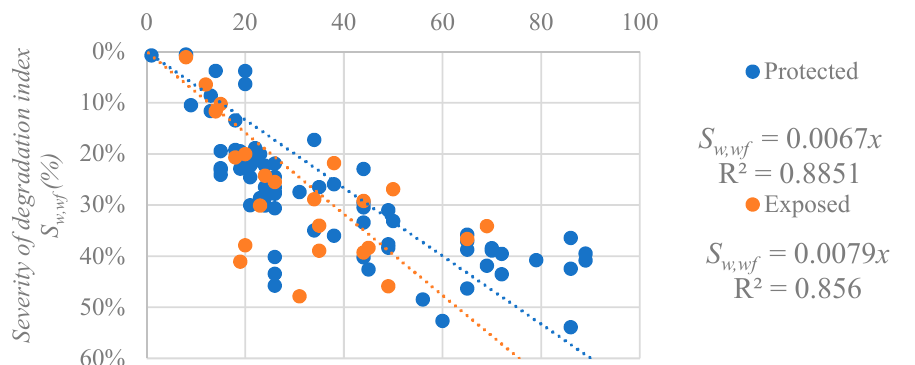
Figure 8. Regression analysis between the numerical index that expresses the degradation of the 96 wood flooring systems ( S w,wf ) and their age, according to the exposure to moisture